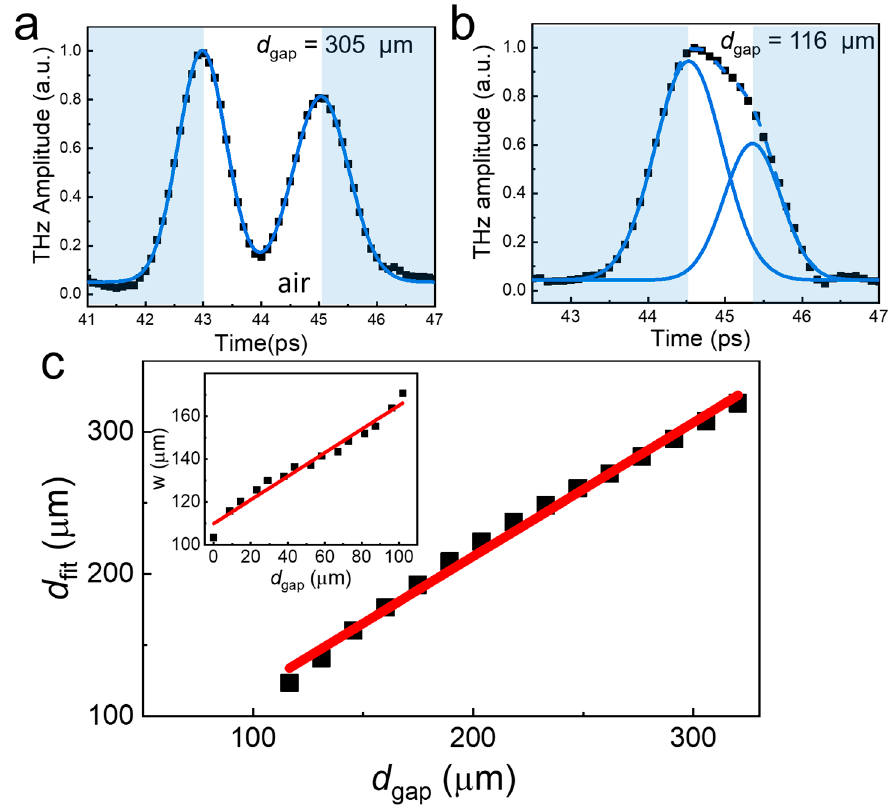
Figure 3. ( a ) A-scan envelope of the reflected waves for the device with an air gap ( d gap ) = 305 μ m enclosed by two quartz substrates. The blue line is a fit to the data with a double Gaussian function. ( b ) A-scan envelope of the reflected waves with d gap = 116 μ m. ( c ) The estimated gap width ( d fit ) by fitting the THz reflection envelope with the double Gaussian functions as a function of d gap as shown in ( a , b ) The red line is a fit to the data with a linear function. (inset). The 1/e 2 halfwidth ( w ) of the Gaussian function was obtained by fitting the THz envelope with a single Gaussian function.